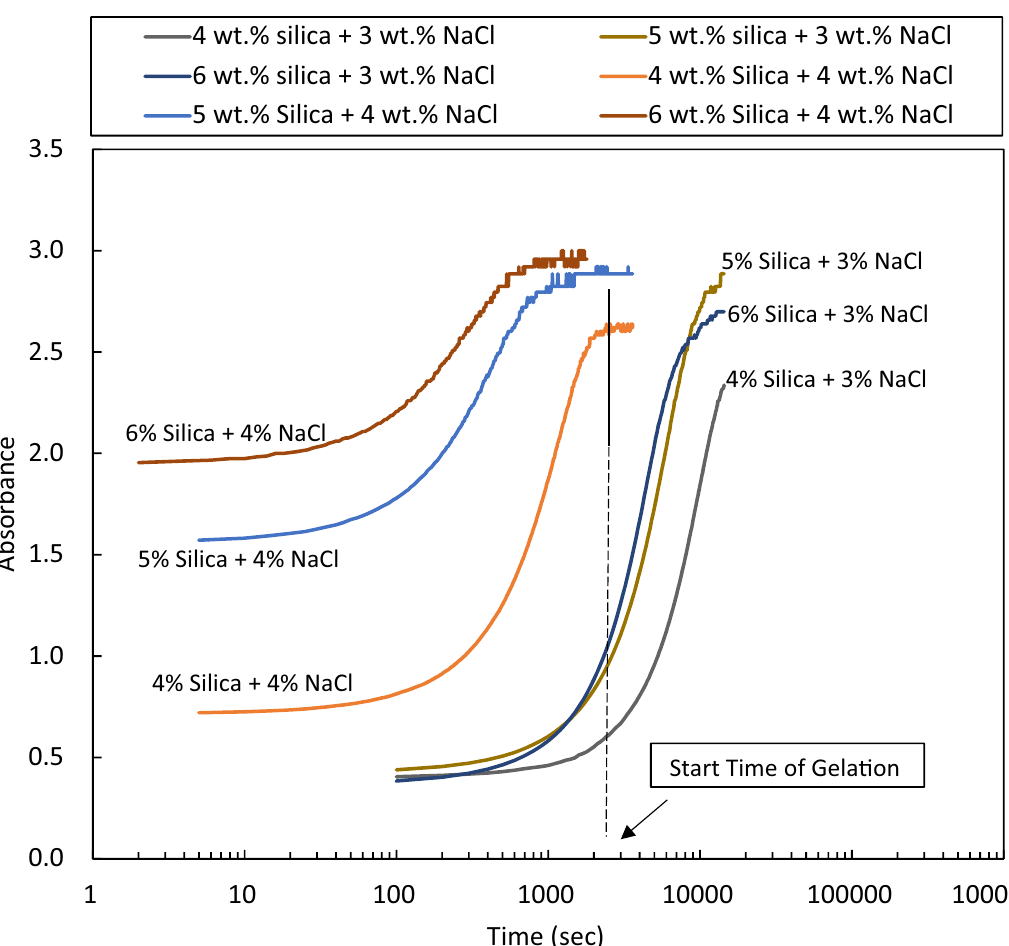
Figure 6. Absorbance versus time for the determination of start time of gelation for solid gels formed from different silica and NaCl concentrations in DIW.